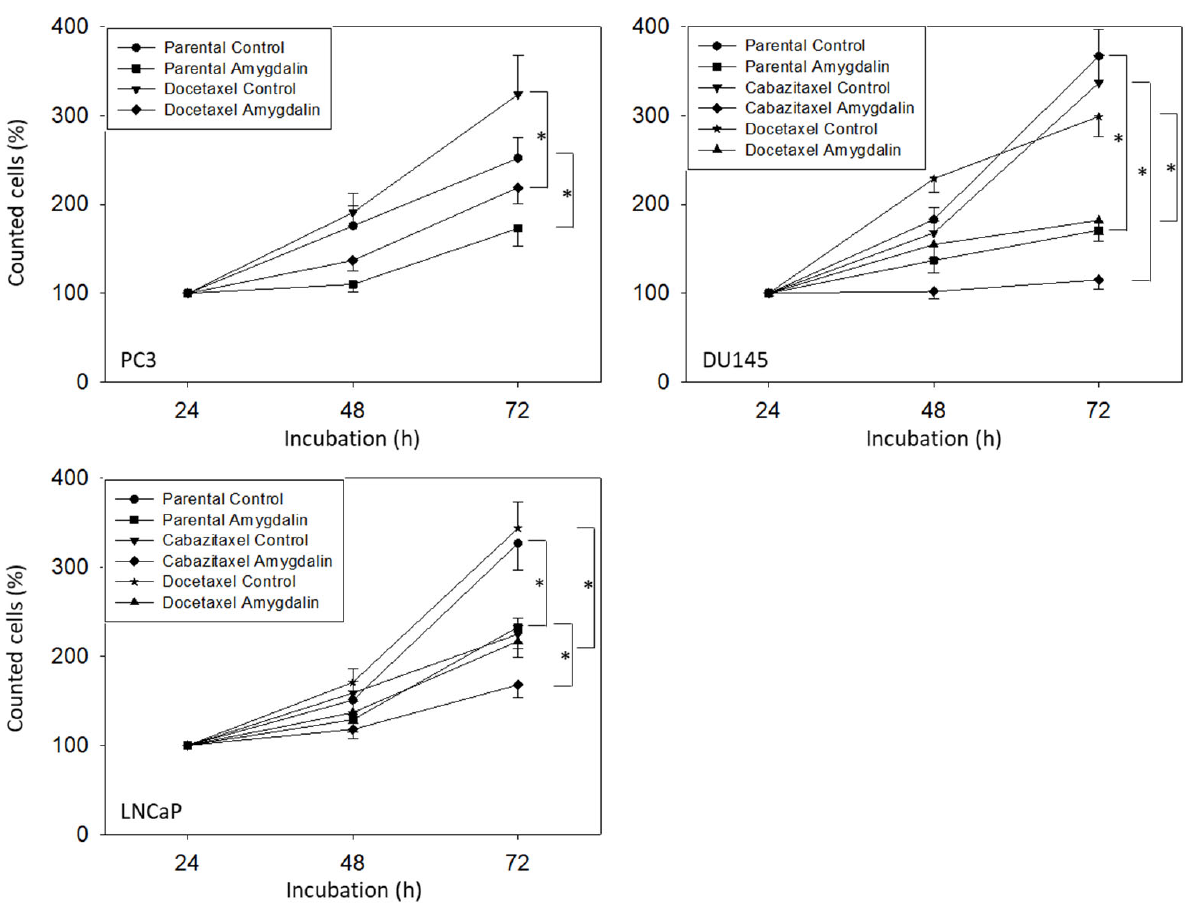
Figure 2. Influence of amygdalin on the growth of parental, cabazitaxel- and docetaxel-resistant PC3, DU145, and LNCaP cell lines. Cell count is related to the 24 h value set to 100%. Error bars indicate standard deviation (SD), n = 5. * indicates significant difference to the corresponding non-treated